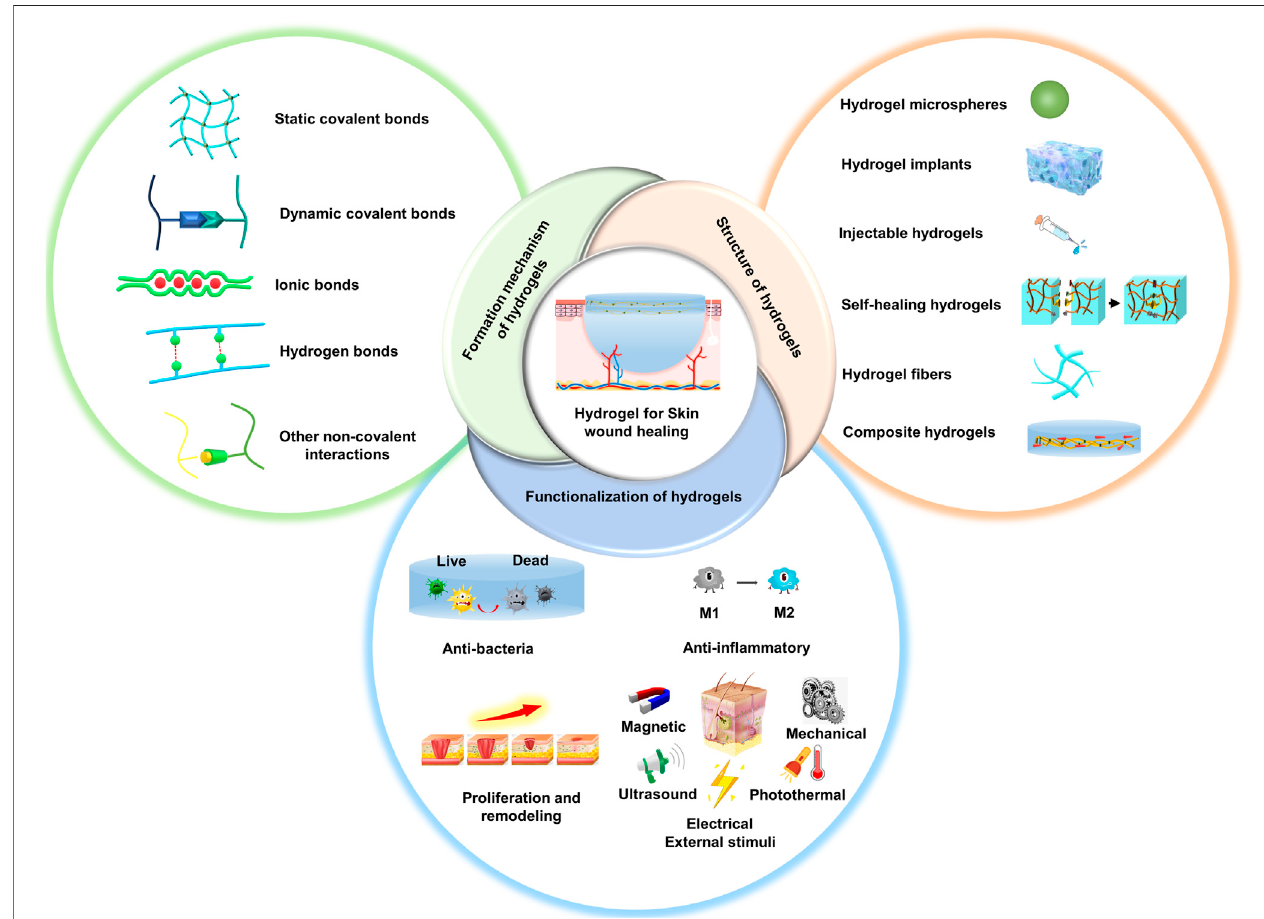
FIGURE 1 | Schematic showing the rational design and preparation of functional hydrogels for skin wound healing.